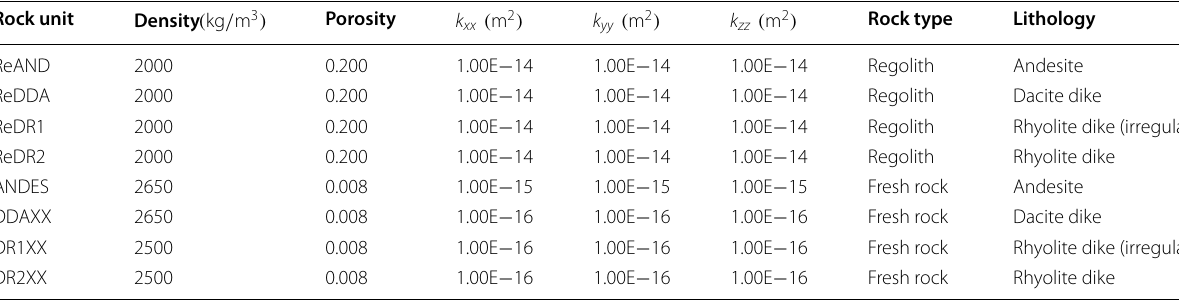
Table 1 Hydrogeologic parameters of the eight rock units considered in the HCM Rock unit Density ( kg / m 3 ) Porosity ReAND